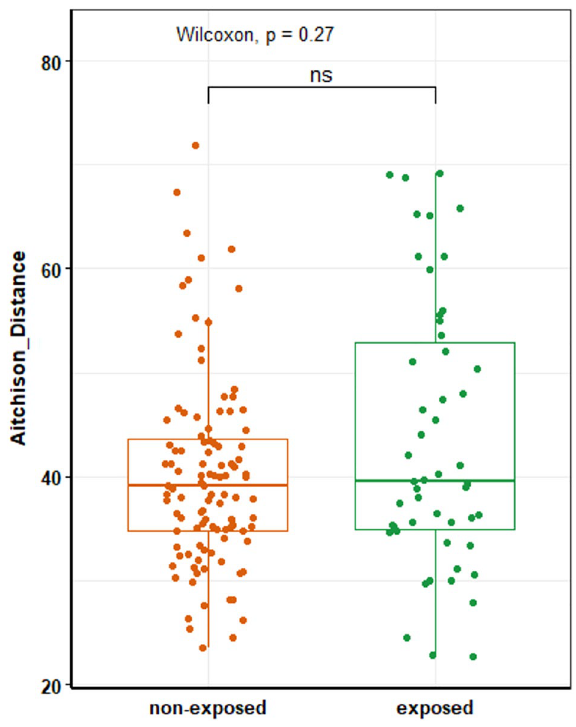
Figure 5. Comparison of within-subject microbiota dissimilarity (Aitchison distance) between samples at the adjacent time point before and after exposure to antibiotics (exposed) versus within-subject microbiota dissimilarity between adjacent samples without intermittent antibiotic